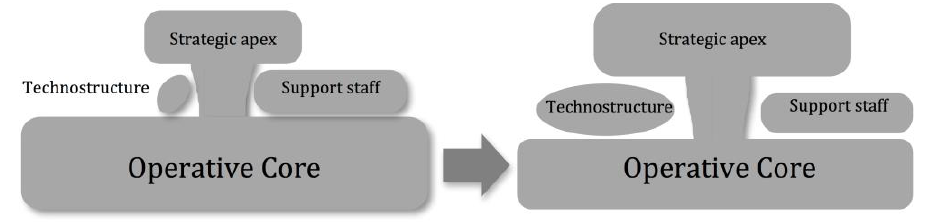
Figure 1. Professional bureaucracy in transformation (Mintzberg 1979, p. 355, modified by the